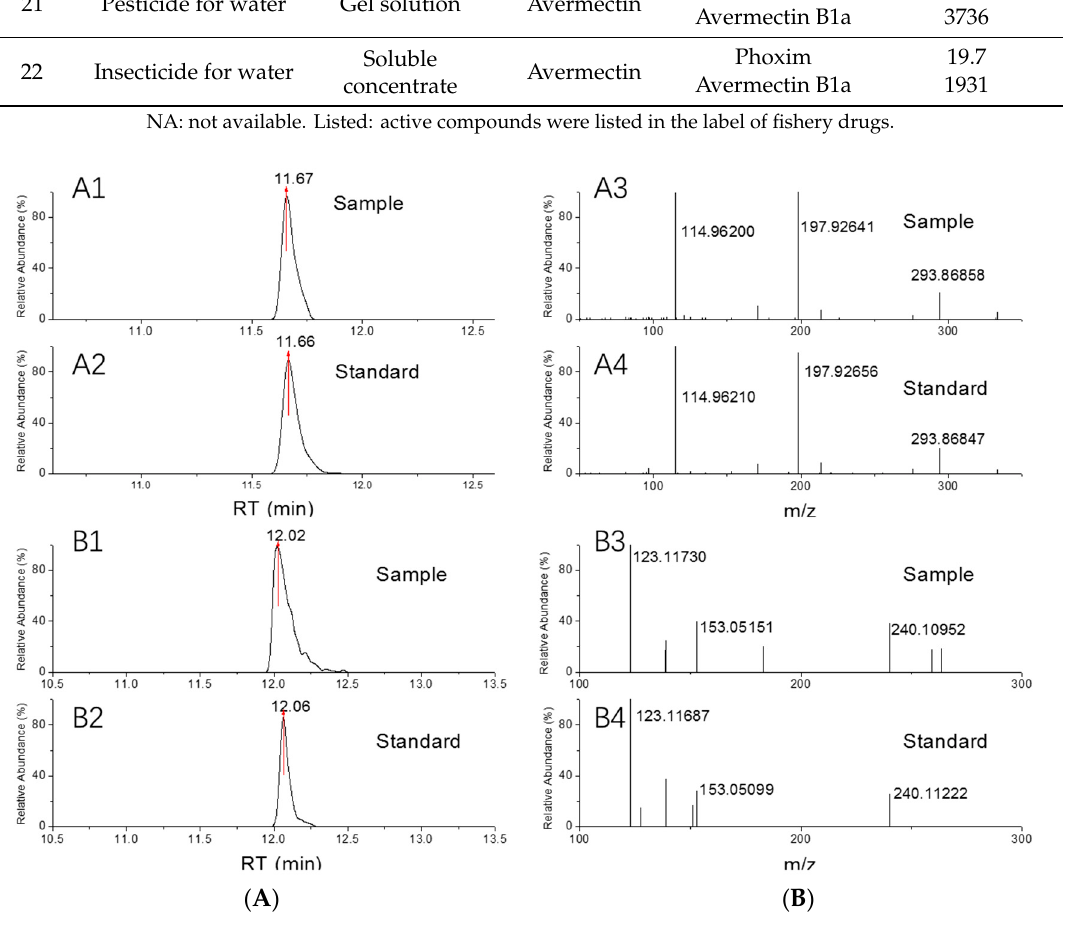
Figure 5. Comparison of the spectra of chlorpyrifos ( A ) and ivermectin B1a ( B ) detected in the positive samples. A1, B1 and A2, B2 are the chromatogram of real samples and standards, respectively. A3, B3 and A4, B4 is the MS/MS spectrum of the positive sample and the standard respectively.